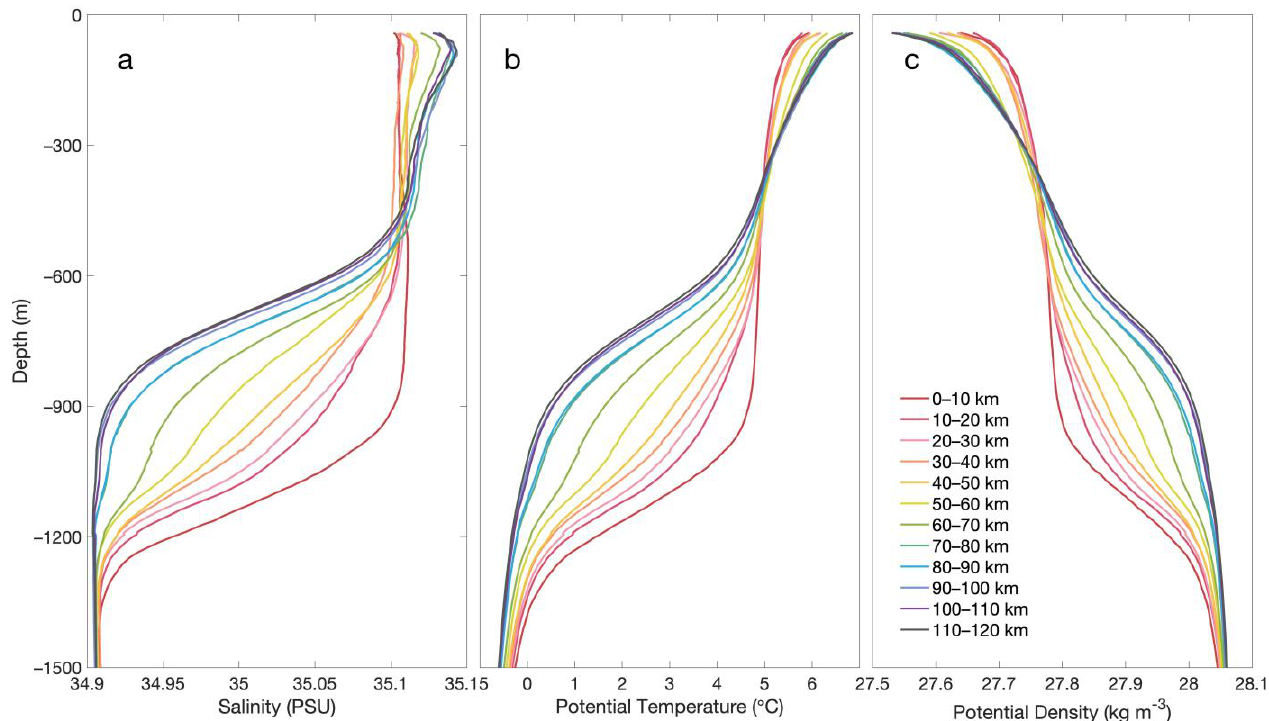
Figure 4. Climatological profiles derived from Argo: ( a ) practical salinity, ( b ) potential temperature, and ( c ) potential density profiles with increasing distance from the center of the CLV.